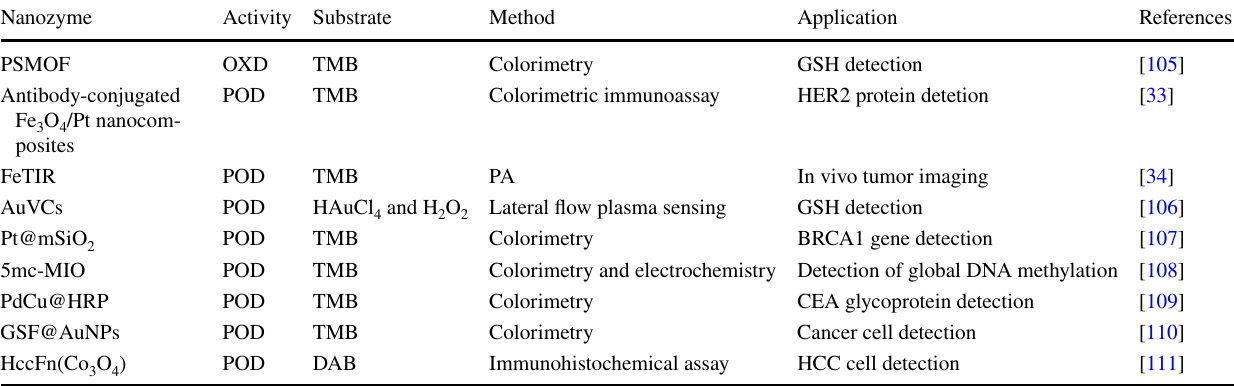
Table 5 Nanozymes for cancer